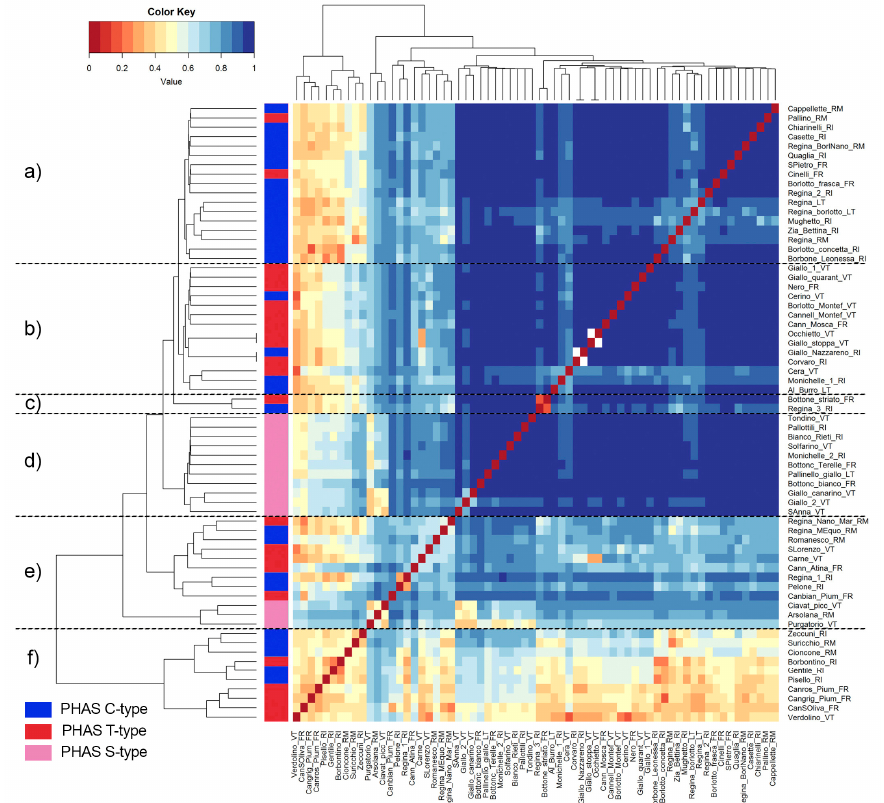
Figure 4. Pairwise Fst heatmap and dendrogram based on Fst values among the 66 landraces of P. vulgaris collected in the Lazio region. The colour key represents the Fst matrix considering different discrete Fst bins, from low (red) to high (blue) genetic differentiation. Phylogenetic trees were developed using the UPGMA method. Different letters (from “( a )” to “( f )”) indicate the main six clusters identified.